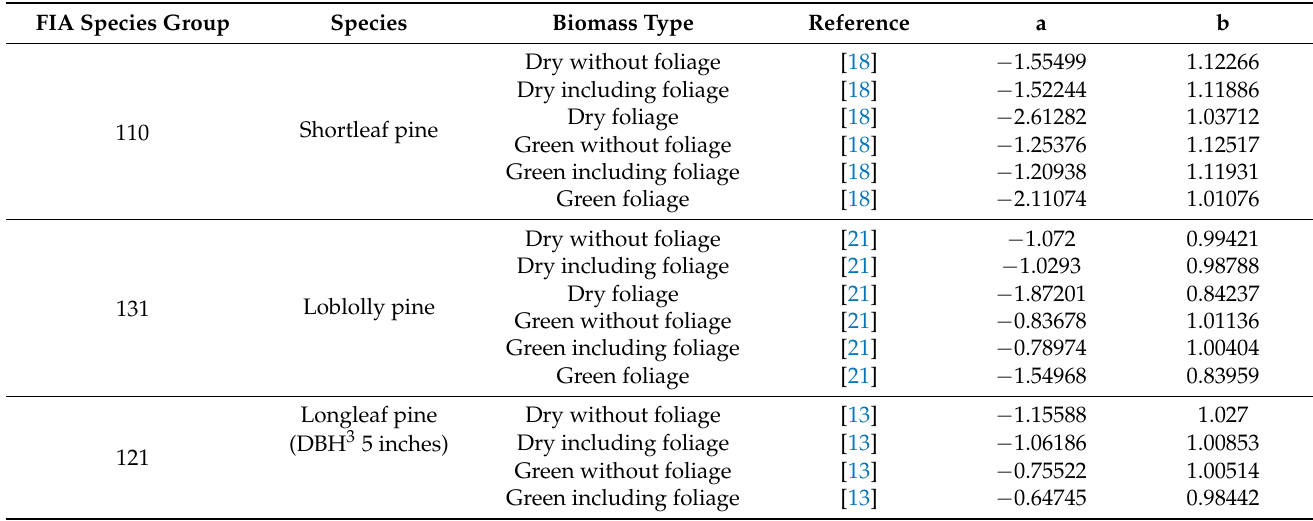
Table A2. Sources of the original equations and parameters of the biomass Equation (2) for softwood